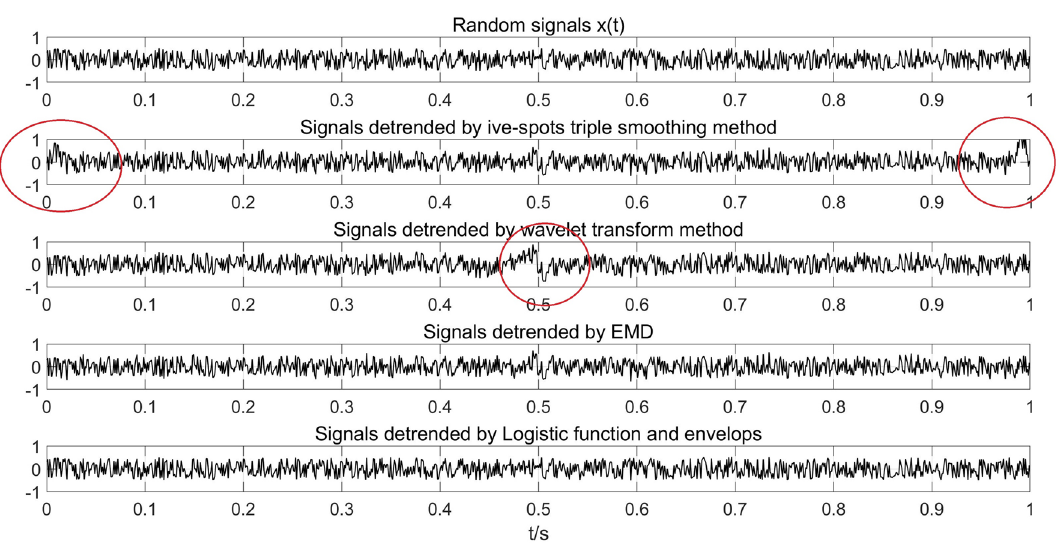
Figure 6. Detrended signals using different